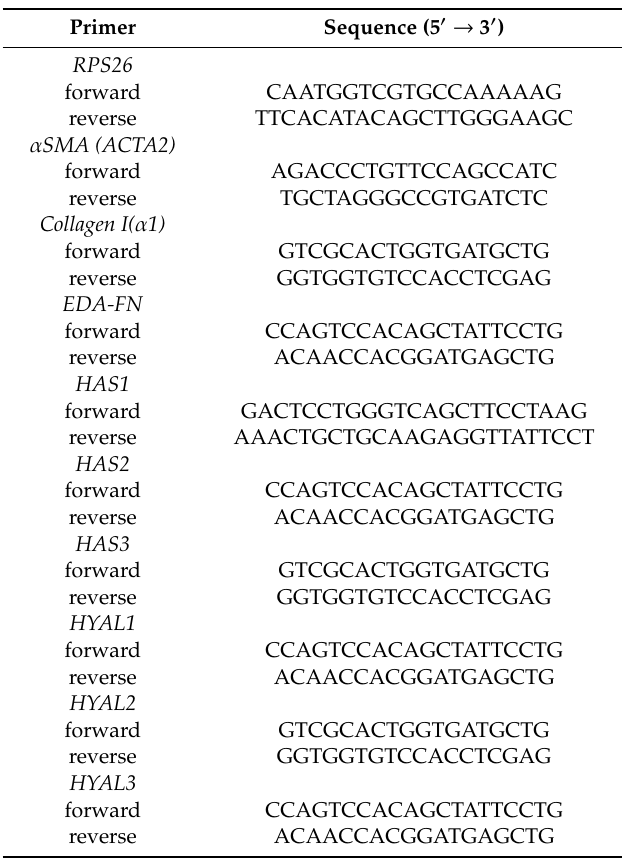
Table 1. RT-qPCR primer sequences used in the